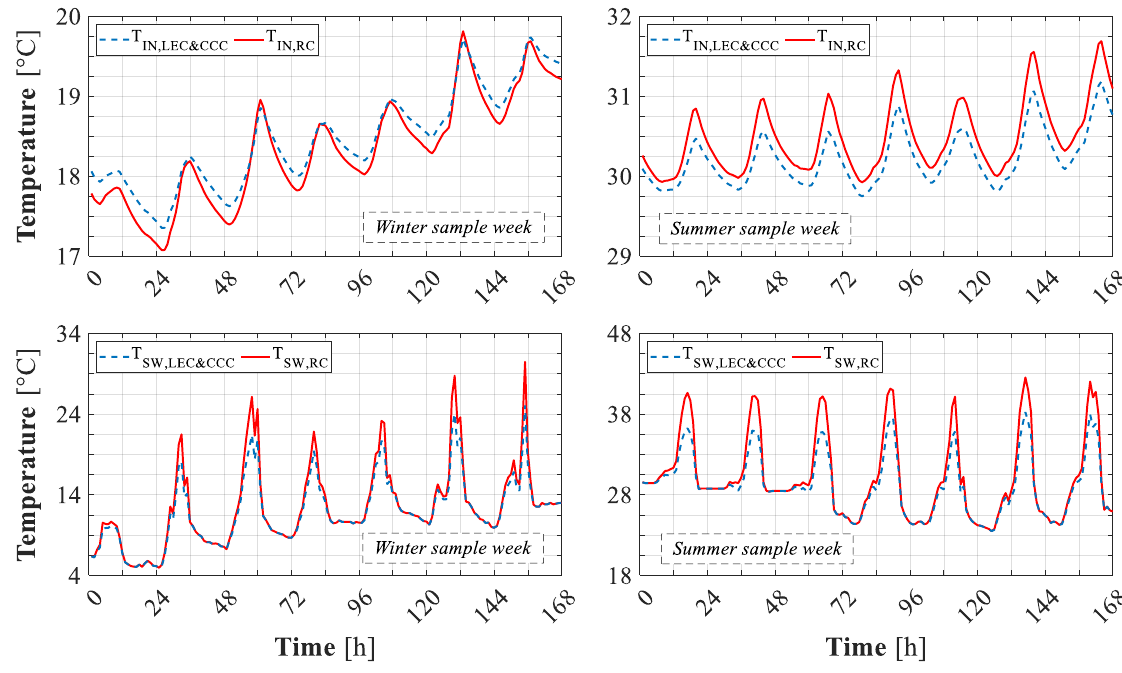
Figure 29. Indoor air and South-West wall internal surface temperature (TIN and TSW, respectively) achieved with low-e plaster and cool coating (LEC & CCC) vs. the reference case (RC)—Winter ( left ) and summer ( right ) sample week.